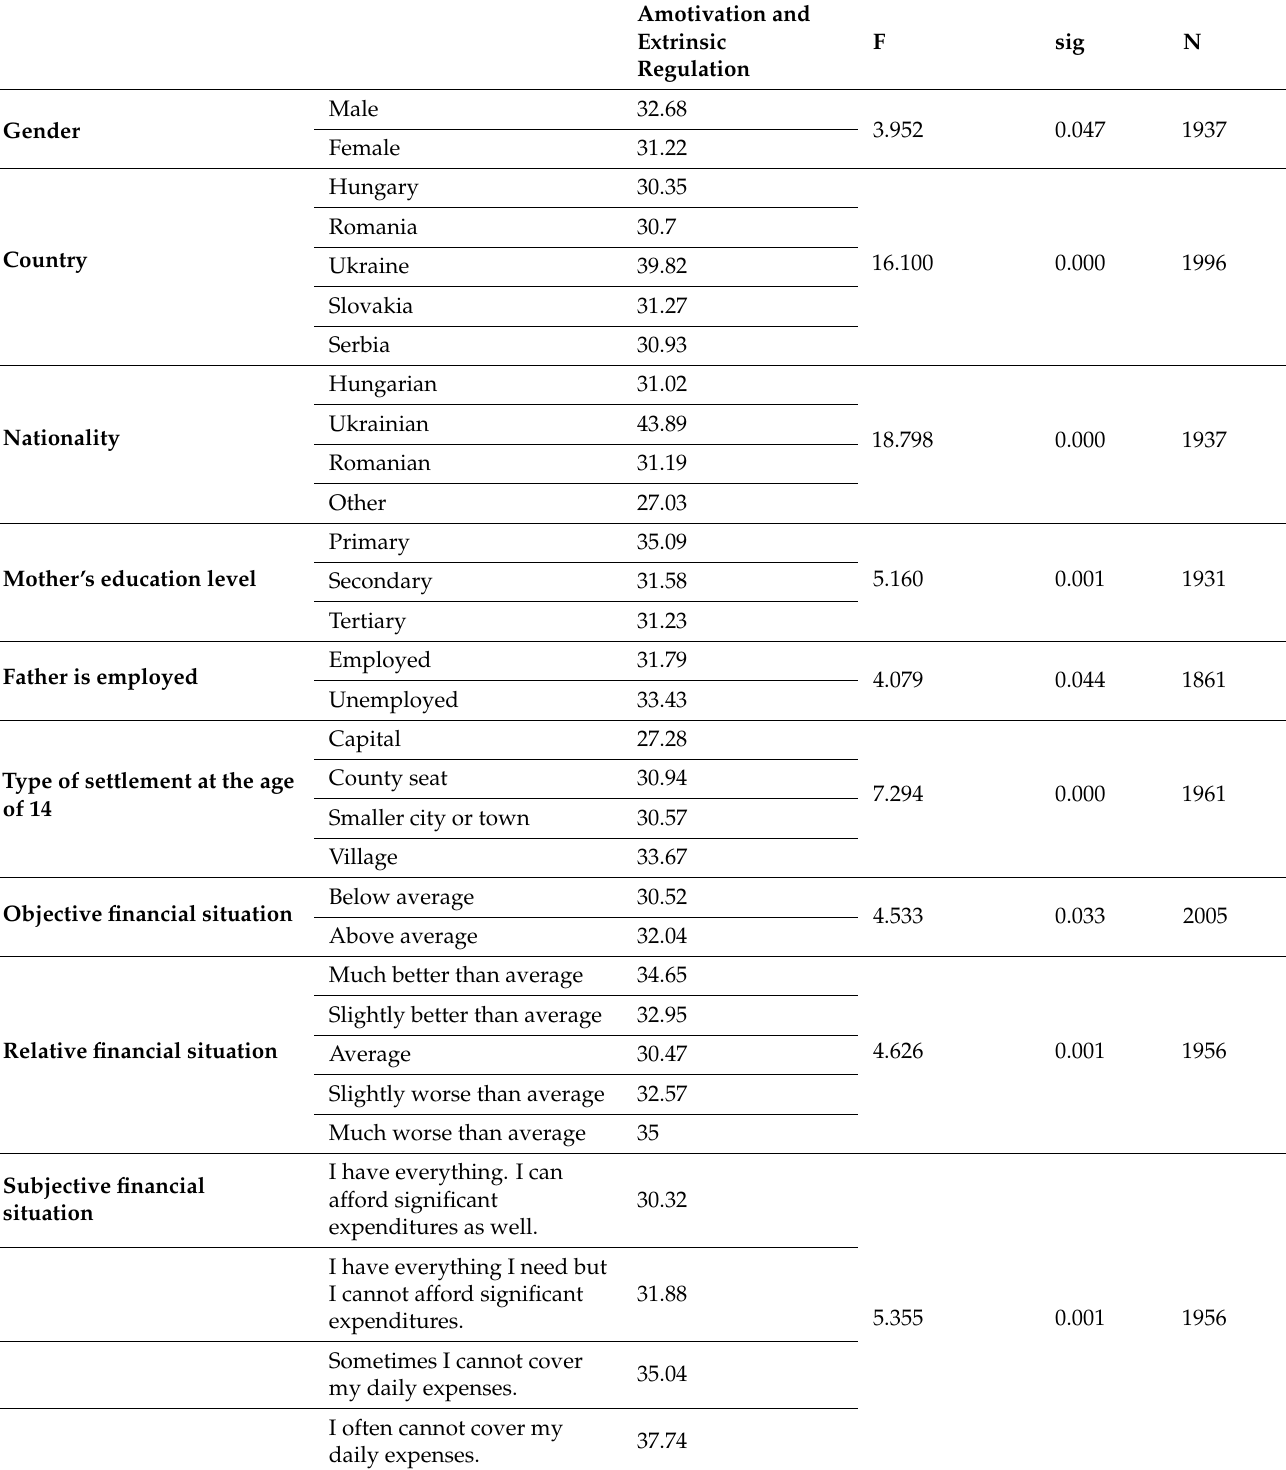
Table A5. Sociocultural and demographic background of amotivation and extrinsic regulation. Source: PERSIST